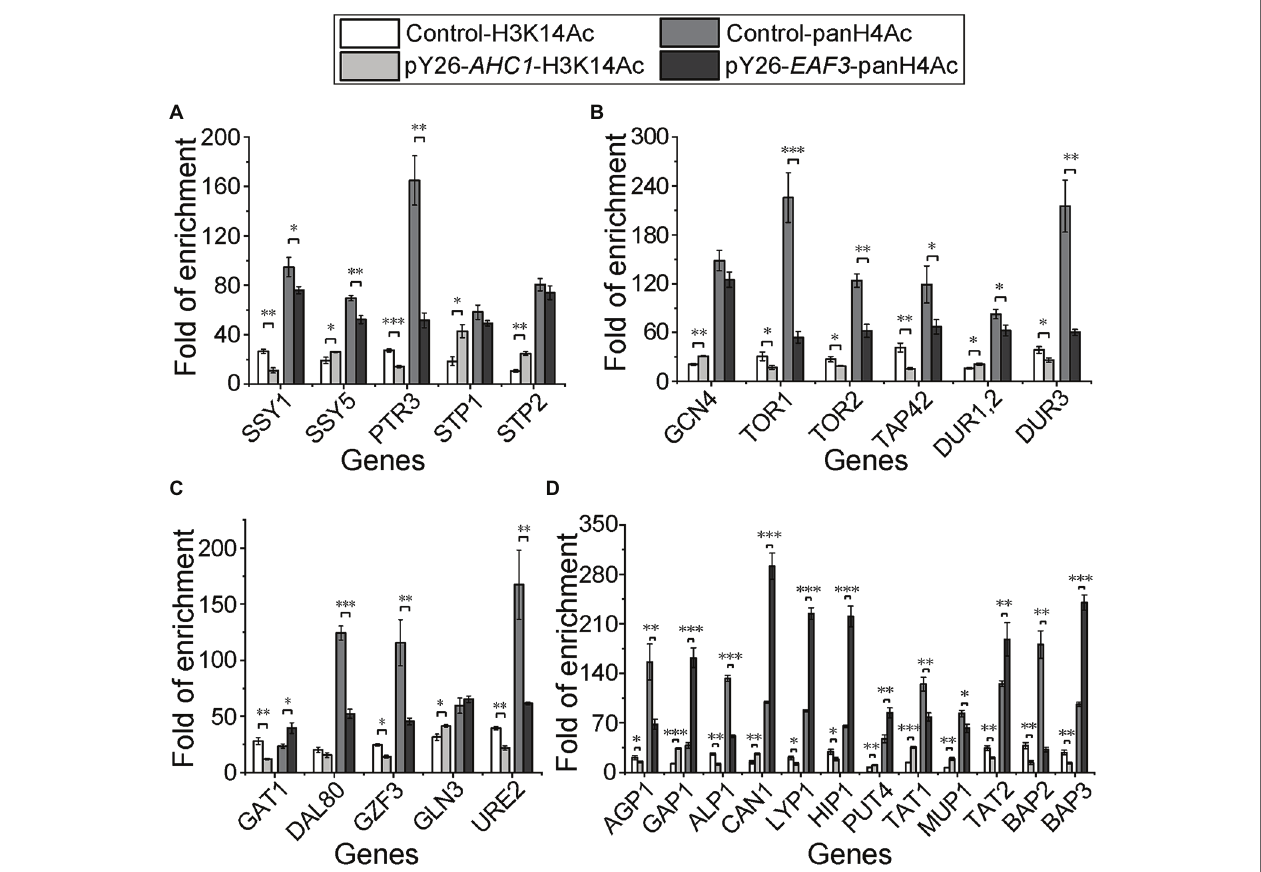
FIGURE 5 | Histone acetylation levels of key nitrogen metabolism genes in AHC1 / EAF3 overexpression strains. (A) Histone acetylation levels of SPS sensor system-related genes. (B) Histone acetylation levels of genes related to the general amino acid control (GAAC) pathway, the TOR pathway, and urea metabolism. (C) Histone acetylation levels of NCR genes. (D) Histone acetylation levels of amino acid transporters. S288C served as a control. Signals were normalized against IgG, and results are mean (M) ± standard deviation (SD) of three biological replicates. Statistical significance was determined by unpaired parametric two-tailed Welch’s t -test with 95% confidence (* p < 0.05, ** p < 0.005, *** p <